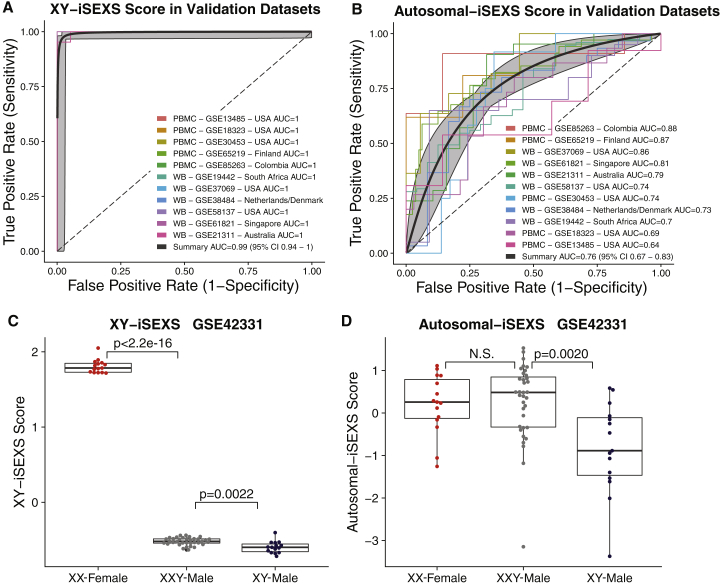
XY-iSEXS and Autosomal-iSEXS Performance in Typical Females, Typical Males, and Klinefelter Syndrome XXY Males(A and B) ROC plots of performance of the (A) XY-iSEXS score (summary AUC 0.99 (95% CI 0.94-1.0)) and the (B) Autosomal-iSEXS score (summary AUC 0.76 (95% CI 0.67-0.83)) to differentiate males and females. Grey areas indicate 95% confidence intervals.(C) Klinefelter syndrome XXY-males have significantly lower XY-iSEXS scores than XX females (t-test p < 2.2e-16) and significantly higher scores than XY-males (t-test p = 0.0022).(D) There is no significant difference between Autosomal-iSEXS scores of XX-females and XXY-males, but XXY-males have significantly higher Autosomal-iSEXS scores than XY-males (t-test p = 0.0020).See also Figures S1 and S2.